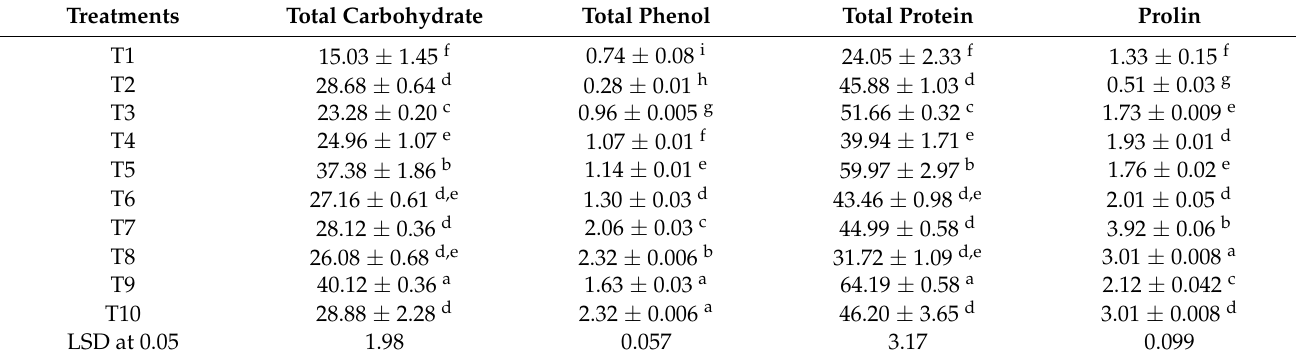
Table 2. Metabolic indicators of tomato plant treated with PGPF.